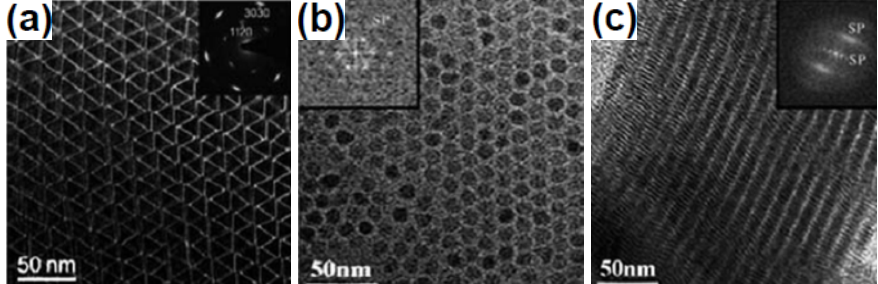
Figure 1. ( a ) TEM image of edge-to-edge super lattices of LaF 3 triangular nanoplates. Reproduced from [18]. Copyright 2005, American Chemical Society. ( b , c ) TEM images of edge-to-edge and face-to-face super lattices of SmF 3 hexagonal nanoplates, respectively. Reproduced from [19]. Copyright 2006, John Wiley and